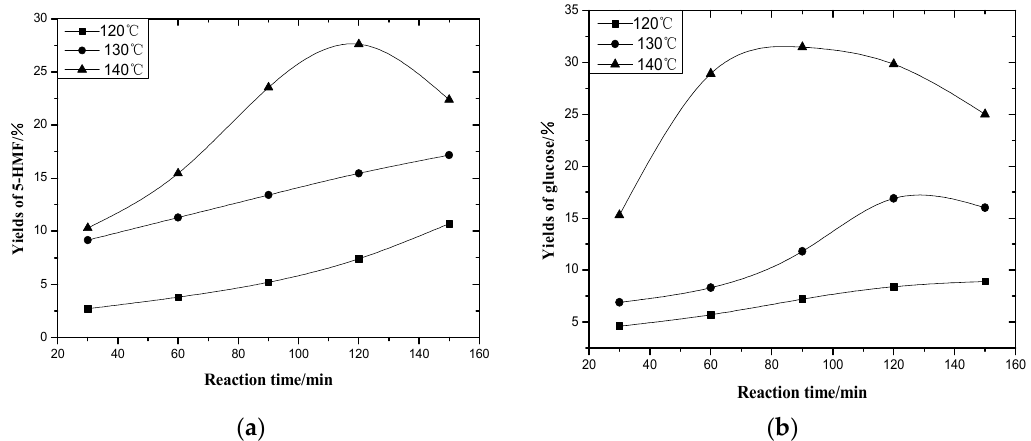
Figure 2. Effect of reaction time and temperature on ( a ) 5-HMF yield and ( b ) glucose yield. Figure 2. E ff ect of reaction time and temperature on ( a ) 5-HMF yield and ( b ) glucose